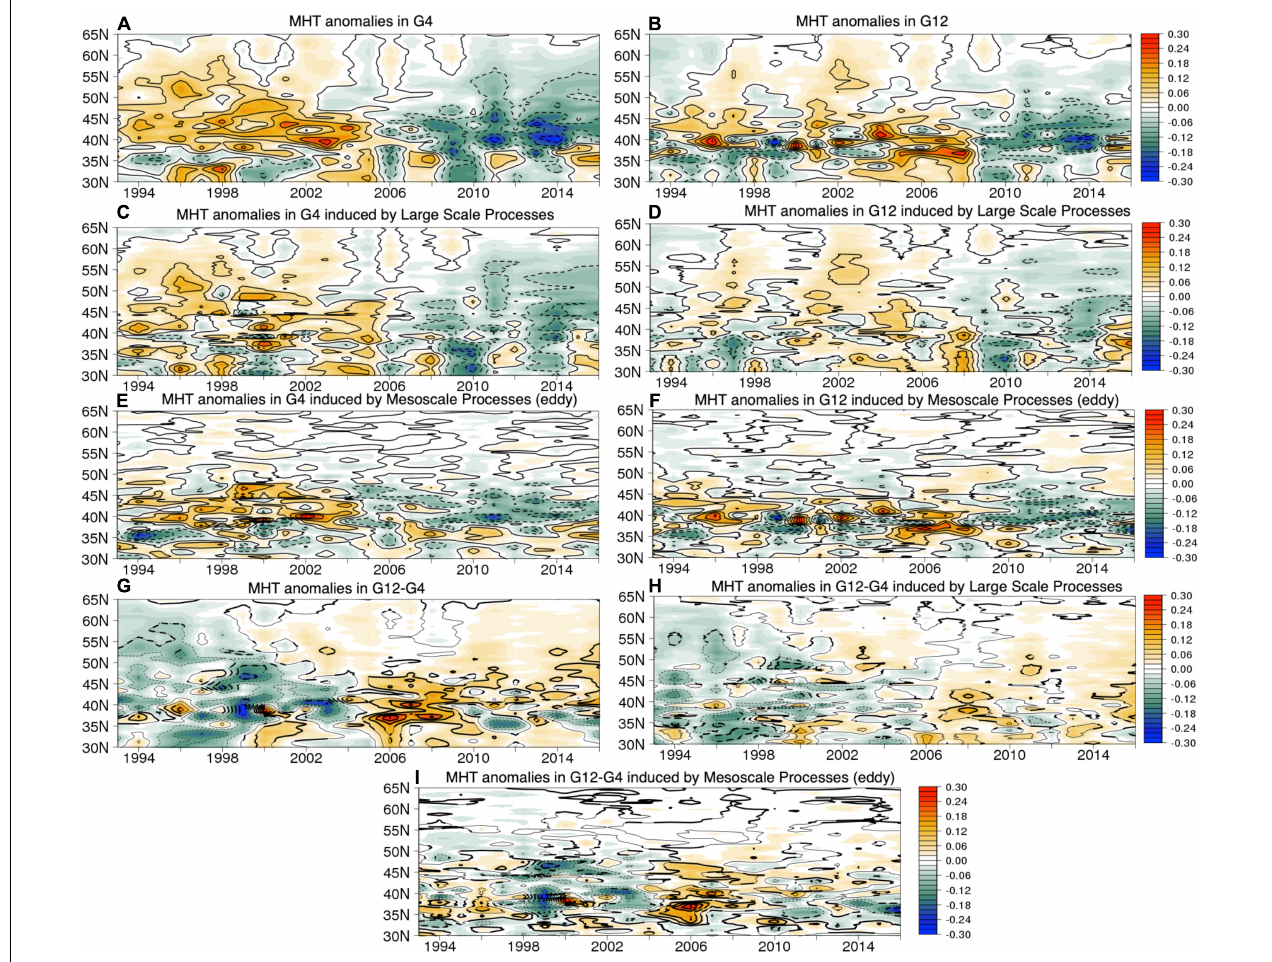
FIGURE 6 | Meridional heat transport anomaly and the anomalies induced by large scale process and mesoscale processes in G4 (A,C,E) and G12 (B,D,F) , differences between G4 and G12 (G,H,I) calculated with 5-day data. In panels (G,H,I) , areas with values that pass t -test 95% confidence interval are indicated in thick contours (unit: